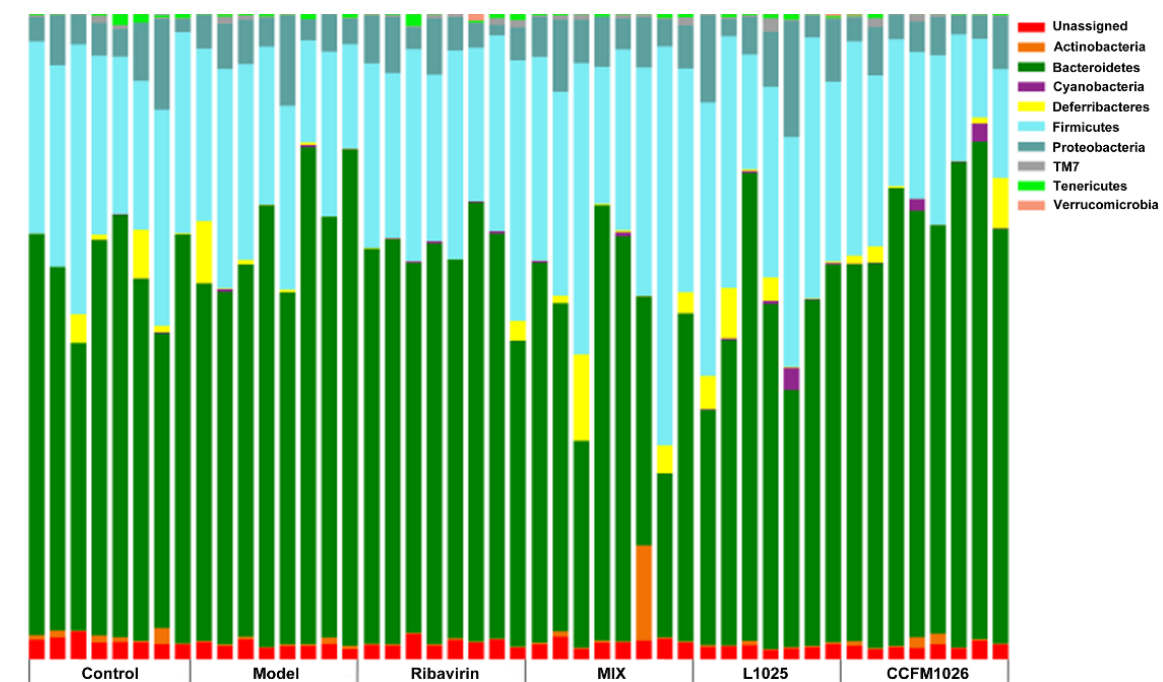
Figure 6. Changes in gut microbiota at the phylum level.